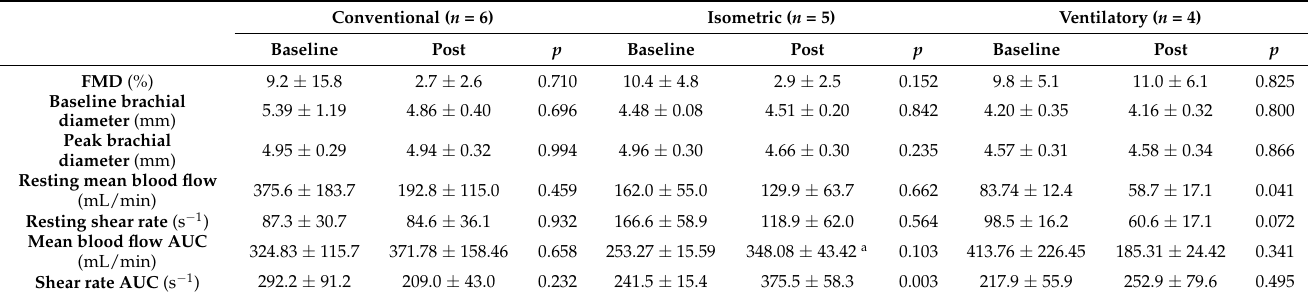
Table 2. Flow-mediated dilatation of brachial artery (baseline) preintervention and (post) postinter- vention in patients undergoing coronary artery bypass grafting.